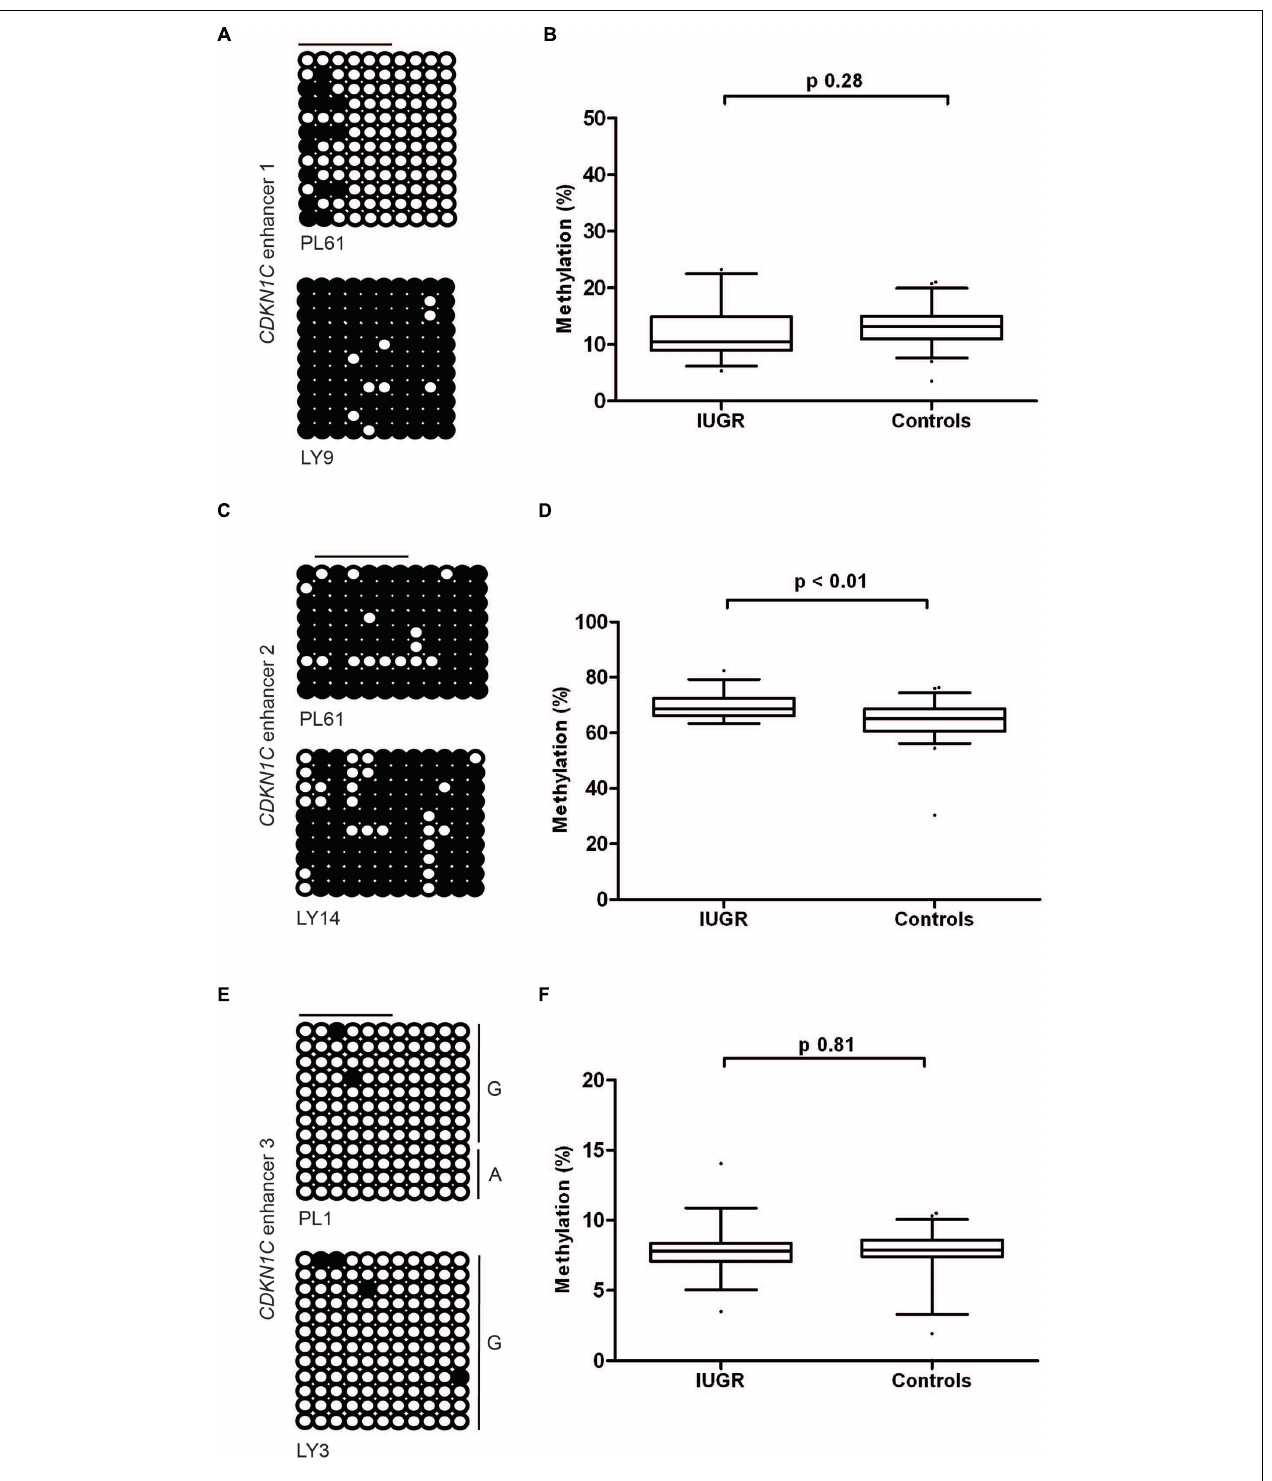
FIGURE 6 | Methylation at the three putative CDKN1C enhancer regions. (A,C,E) The figures represent bisulfite PCR and sequencing for placenta and leukocytes samples where each row corresponds to an individual sequenced DNA clone. Each circle represents a CpG on the strand, and filled circles and open circles indicate methylated and unmethylated sites, respectively. Horizontal lines indicate the CpG sites analyzed by pyrosequencing. (B,D,F) The methylation profiles, representing the average methylation of assayed CpGs as determined by pyrosequencing in IUGR and control control placenta samples. PL, placenta; LY,